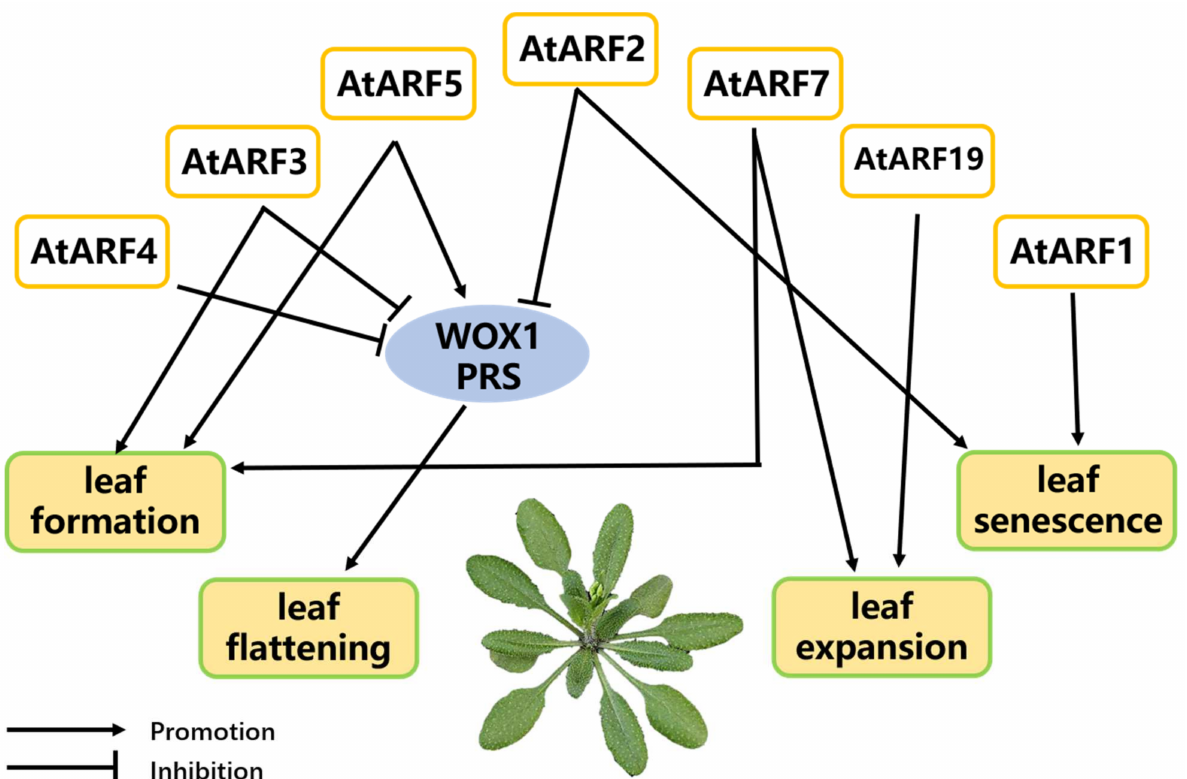
Figure 2. A model of ARFs involved in leaf development and senescence in Arabidopsis thaliana . ARF2/3/4/5 regulates leaf flattening by targeting the promoters of WUSCHEL-RELATED HOME- OBOX1 (WOX1) and PRESSED FLOWER (PRS). ARF3/5/7 synergistically regulate the leaf formation process. ARF 7 and 19 affect leaf expansion. ARF1 and 2 promote leaf